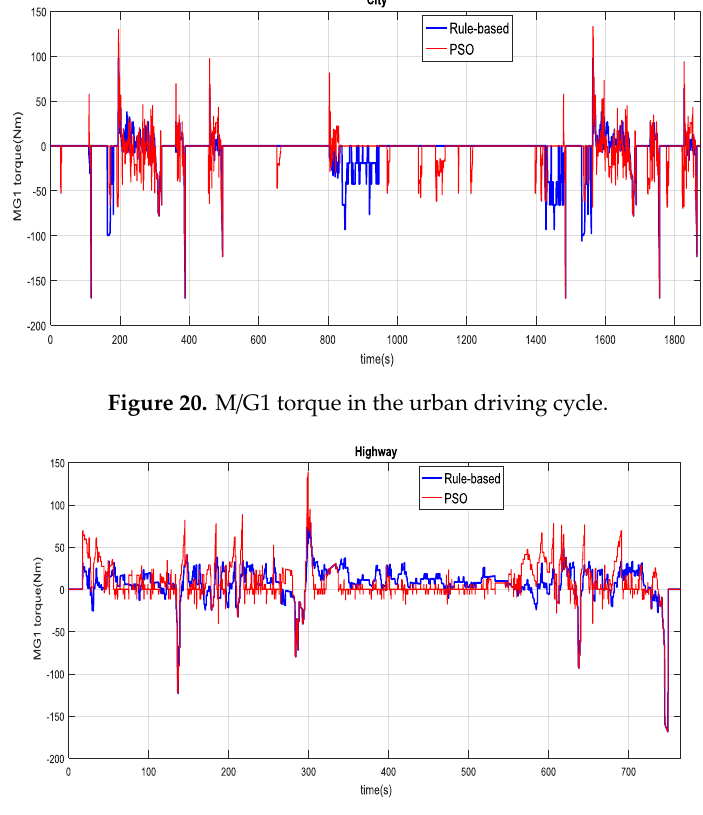
Figure 19. Comparison of highway engine operating points.